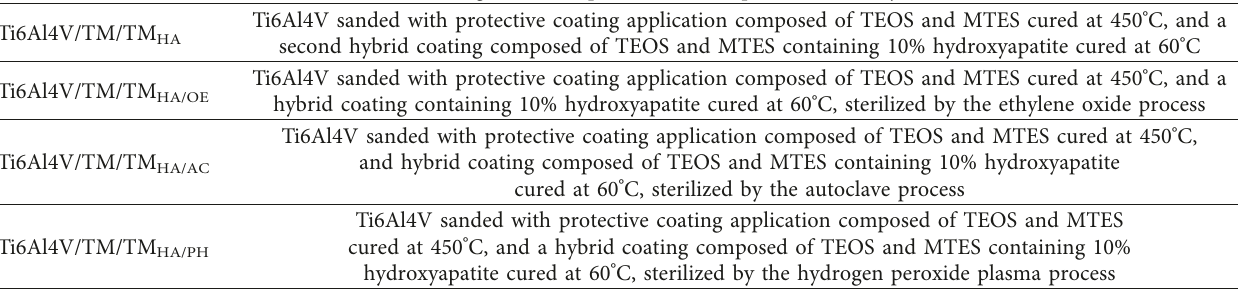
Table 1: Naming and description of the samples of this study.